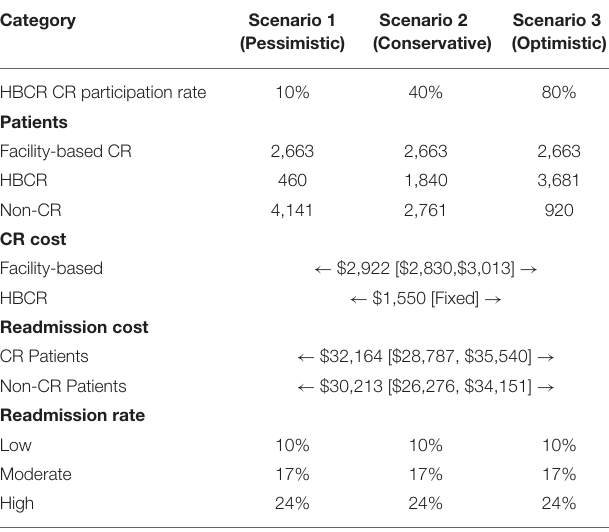
TABLE 1 | Variables used in economic impact